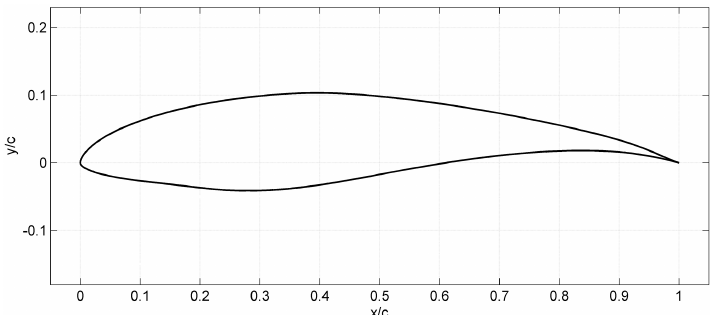
Figure 1. NREL S826 airfoil